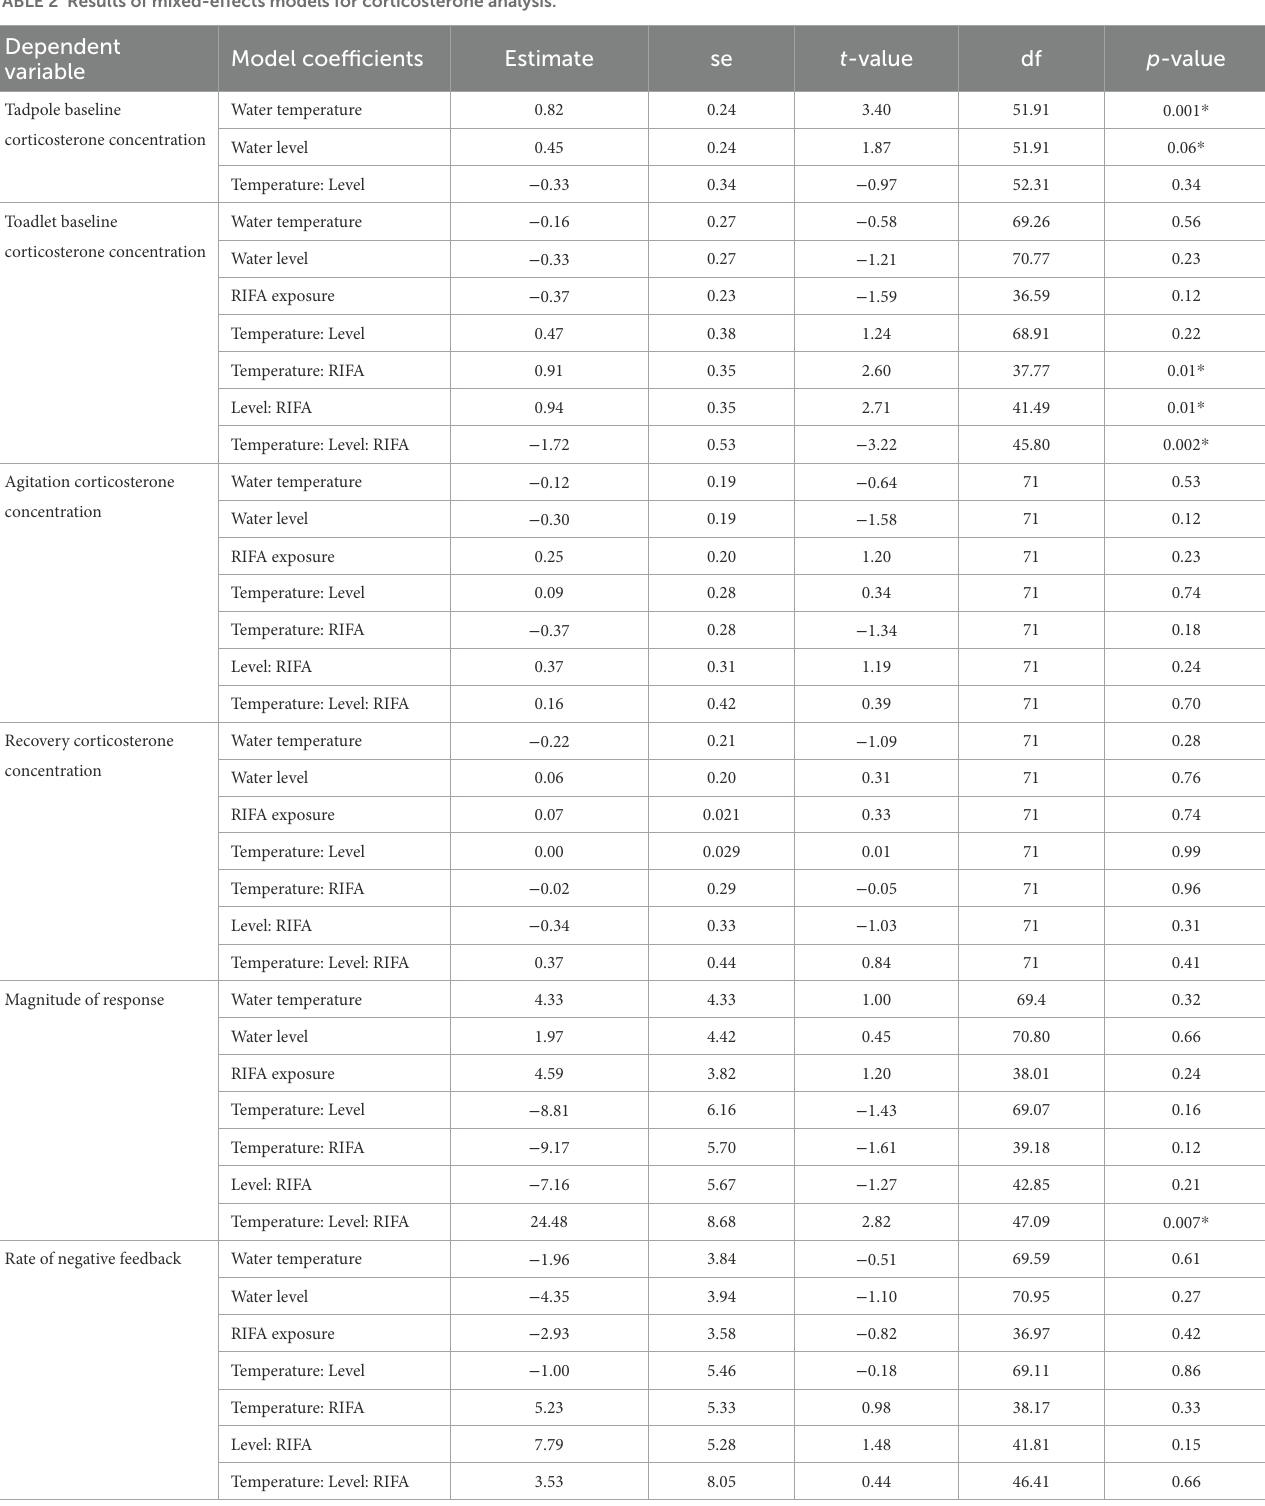
TABLE 2 Results of mixed-effects models for corticosterone analysis. Dependent